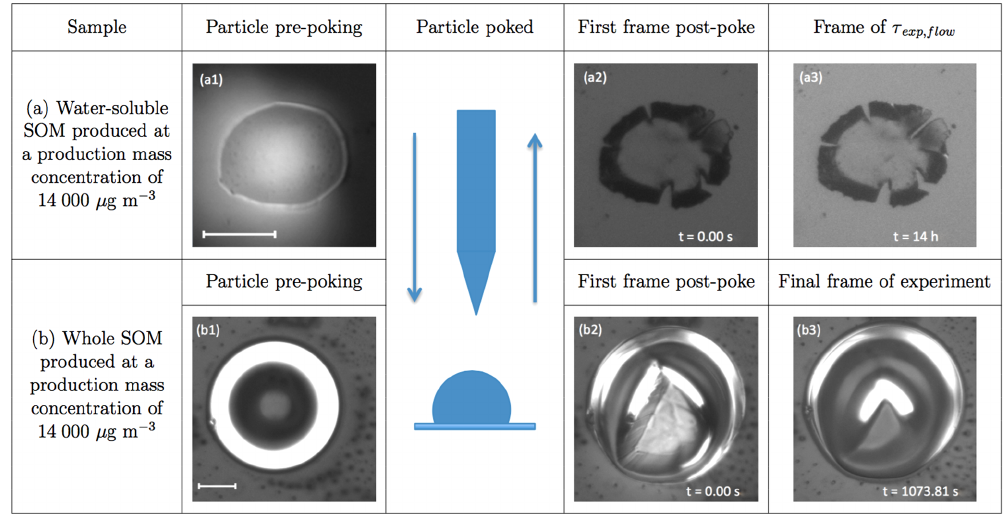
Figure 6. Optical images recorded during poke-and-flow experiments using particles consisting of (a) the water-soluble component of the SOM and (b) the whole SOM (i.e., both the water-soluble and the water-insoluble components). In both experiments the SOM was produced using a mass concentration of 14000µgm − 3 and was poked at <0.5% RH. Panels (a1) and (b1) correspond to the SOM prior to being poked. The brightness in panel (a1) is due to reflection of the source light by the needle positioned just above the particle. Panels (a2) and (b2) correspond to the first frame post-poke (i.e. the first frame after the needle has been removed). The particle comprised of the water- soluble component of SOM exhibited cracking behaviour and, as shown in panel (a3) , no change in the size or shape of the cracks can be observed 14h after the particle has been poked. The particle comprised of whole SOM exhibited flow, and panel (b3) corresponds to an image of the particle at its experimental flow time, τ exp, flow , the point at which the diameter of the hole at the centre of the torus has decreased to 50% of its original size. Scale bar in panels (a1) and (b1) : 20µm.